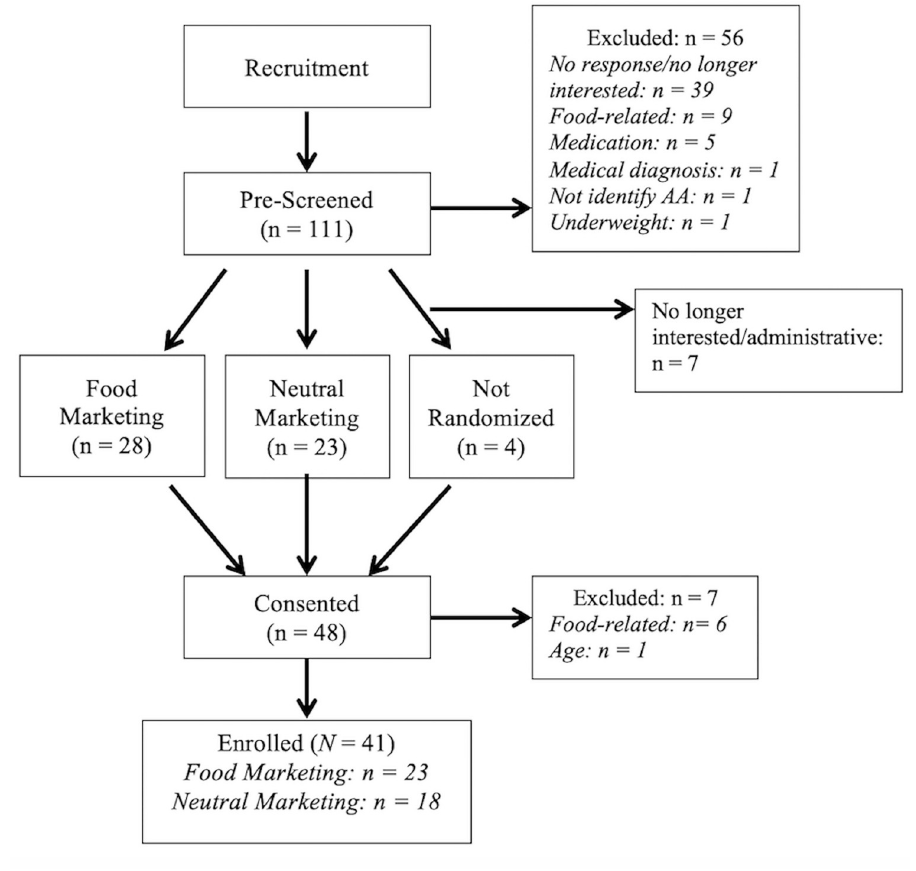
Fig 1. Study flow. Illustration detailing the flow of study participants from recruitment to